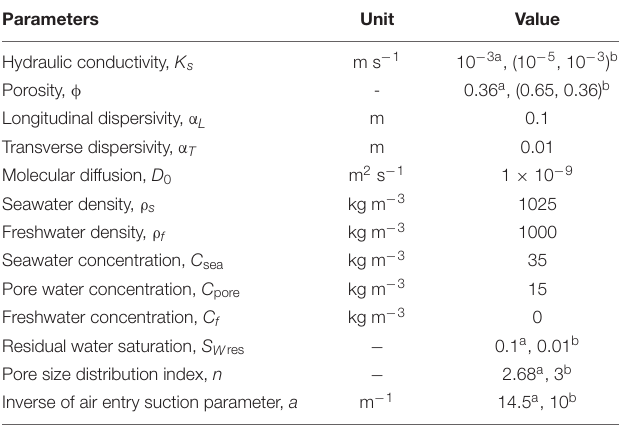
a Parameter values for Case H (homogeneous, sand soil). b Parameter values for Case L (stratified), and numbers in the parentheses correspond to the upper mud layer and the deeper sandy layer,